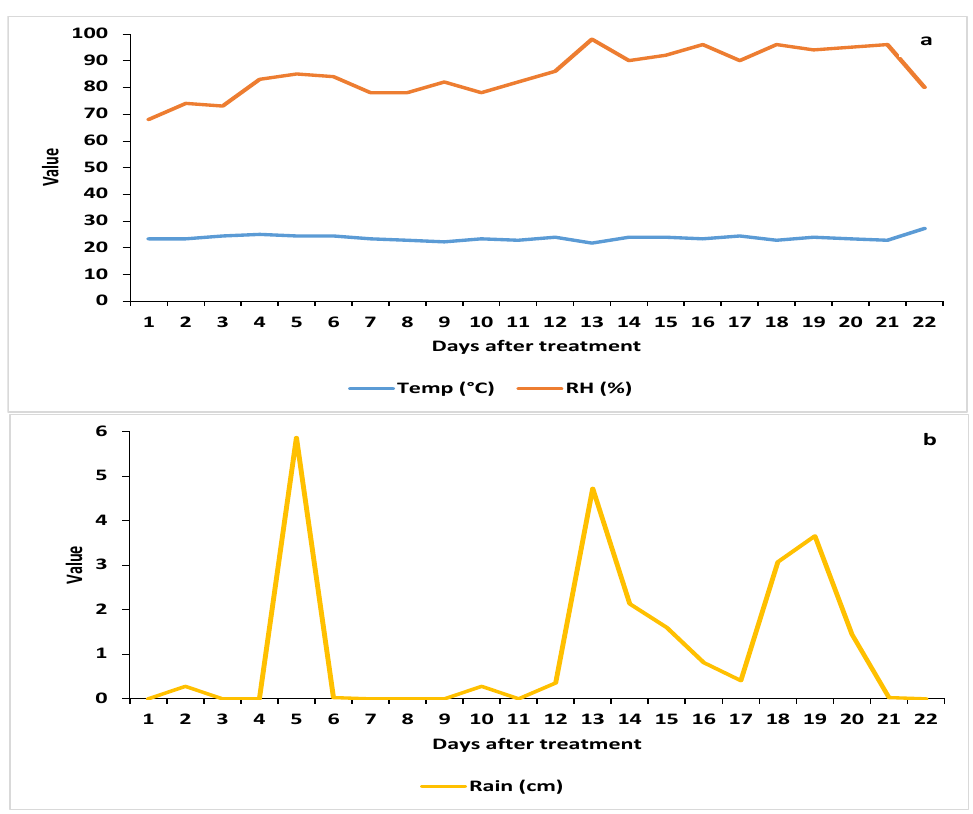
Figure 1. Daily weather parameters during the study in 2018: ( a ) mean temperature and relative humidity; ( b )